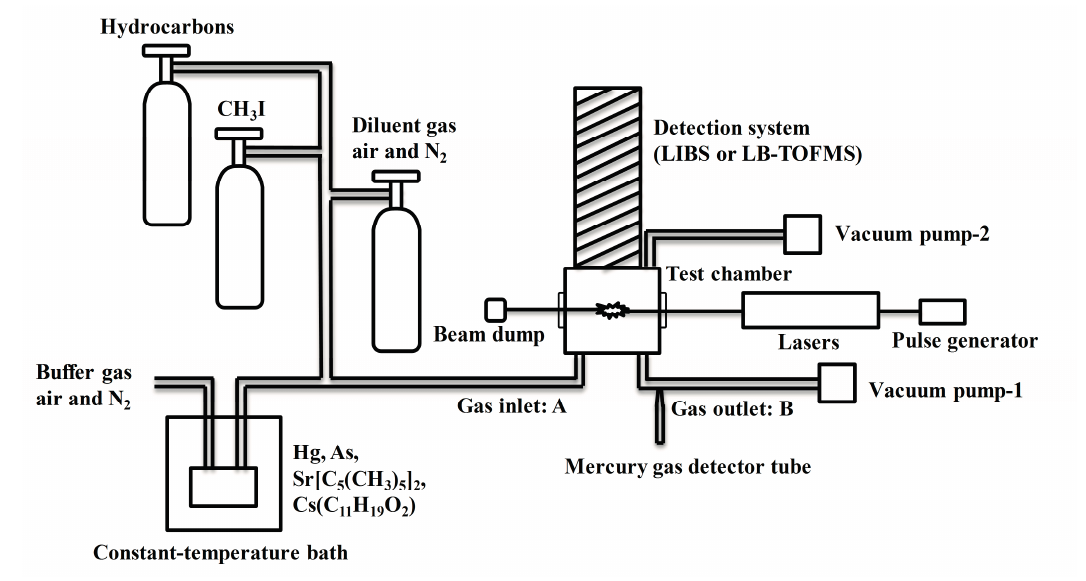
Figure 2. Schematic diagram of the experimental